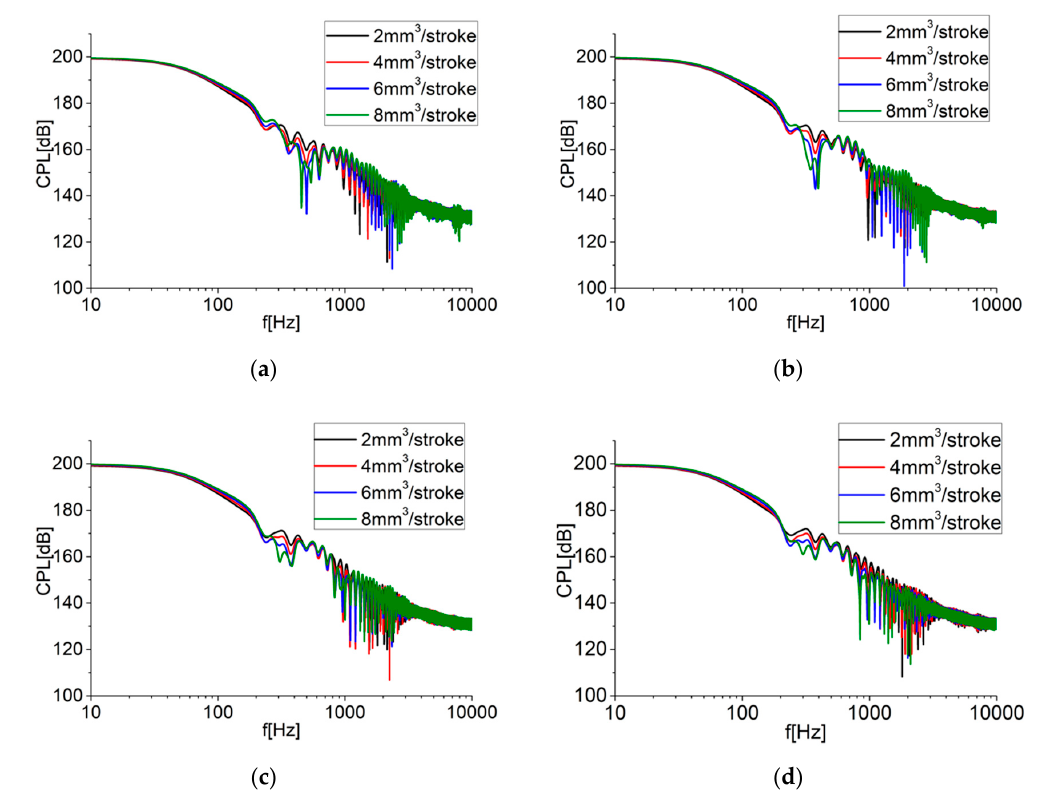
Figure 4. Cylinder pressure levels. ( a ) Pilot injection timing = − 9° ATDC; ( b ) pilot injection timing = − 14° ATDC; ( c ) pilot injection timing = − 19° ATDC; ( d ) pilot injection timing = − 24° ATDC.